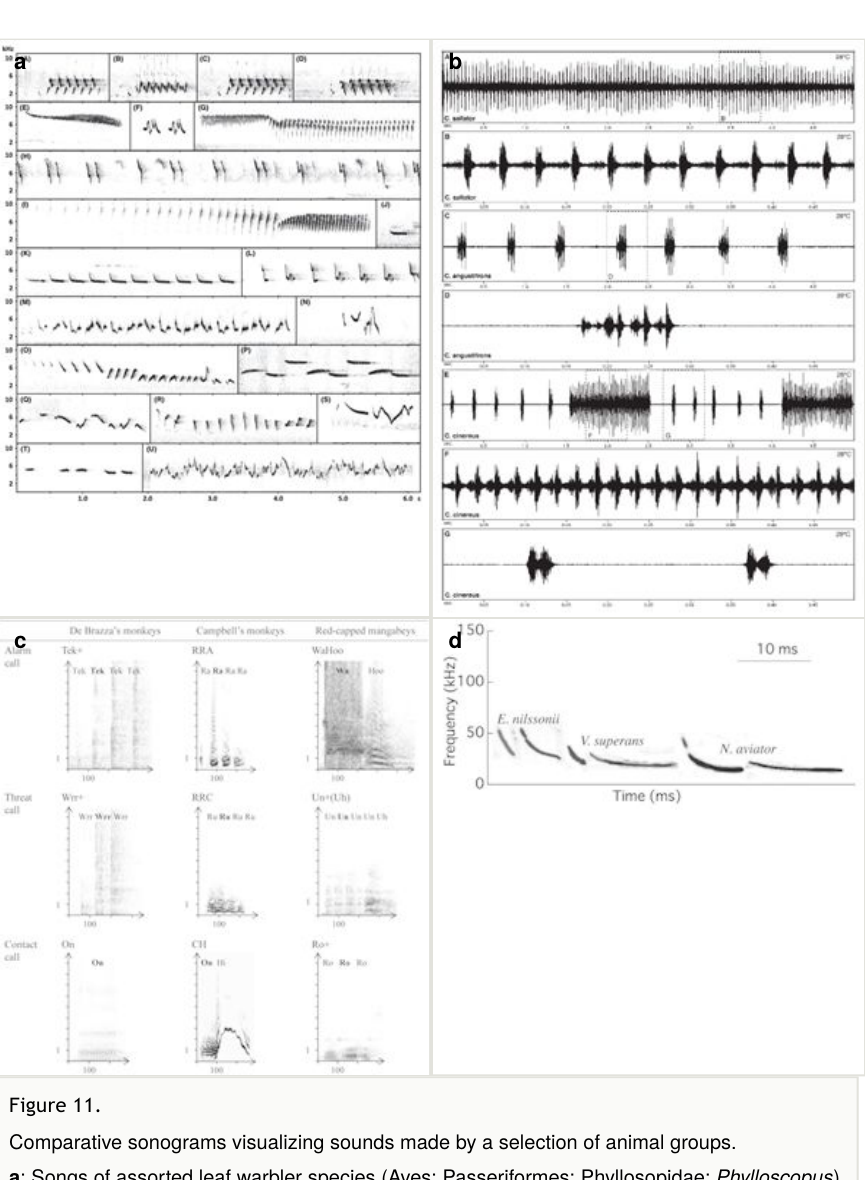
Comparative sonograms visualizing sounds made by a selection of animal groups. a : Songs of assorted leaf warbler species (Aves: Passeriformes: Phyllosopidae: Phylloscopus ), from Tietze et al. (2015). b : Oscillograms showing two types of male airborne calls from three species of katydid (Insecta: Orthoptera: Tettigoniidae: Conocephalus ), from Naskrecki (2000). c : Three di ff erent call types (alarm, threat, and contact) across three monkey species (Mammalia: Primates: Cercopithecidae), from Bouchet et al. (2013). d : Echolocation calls of three bat species, two of each included to show some intraspeci fi c variation (Mammalia: Chiroptera: Vespertilionidae), from Fukui et al.